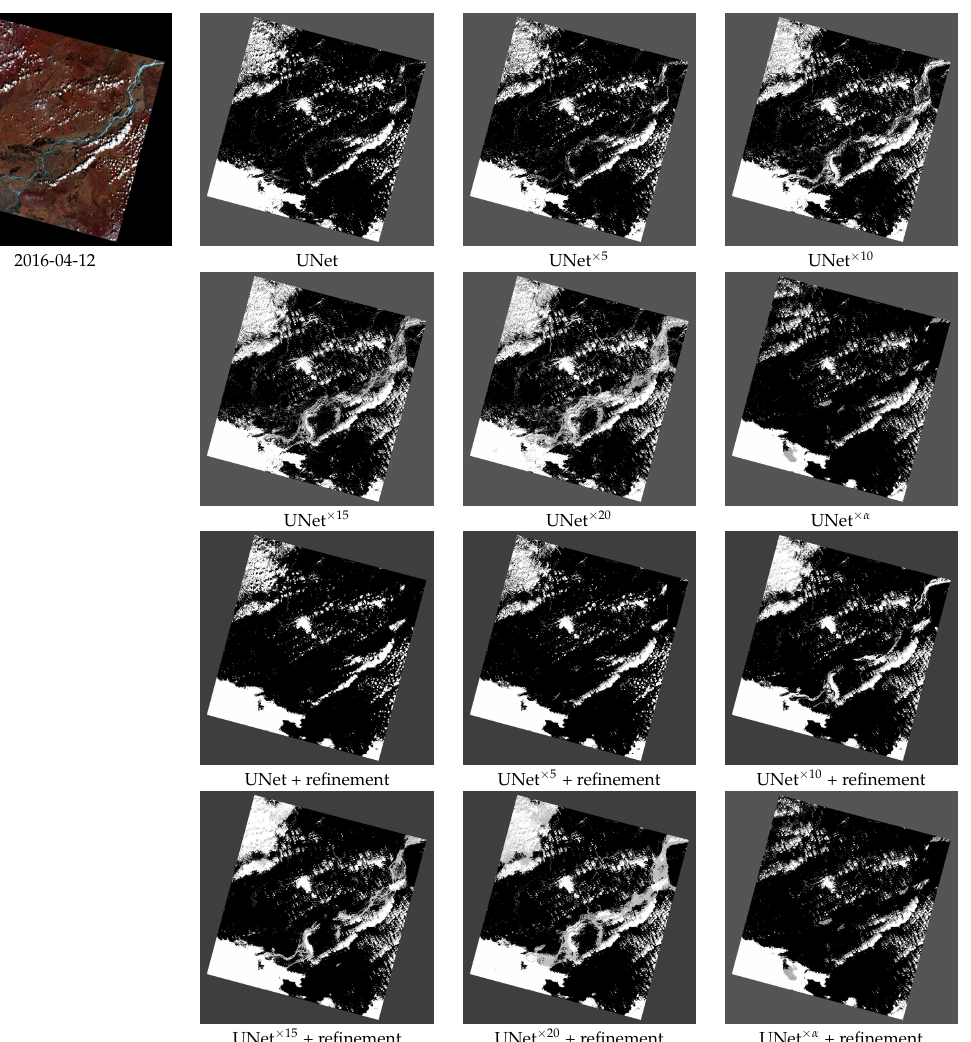
Figure 13. Effect of the fixed and adaptive classification weights (L8, Path 113, Row 26). Bands 5 NIR, 4 Red, and 3 Green are combined together as RGB channels to construct a false-color image for visualization. Fixed weights of × 5, × 10, × 15, and × 20 for cloud shadow can drive the UNet to retrieve more pixels but lead to severe classification biases. The adaptive weight × α dynamically adjust the classification performance to retrieve more proper